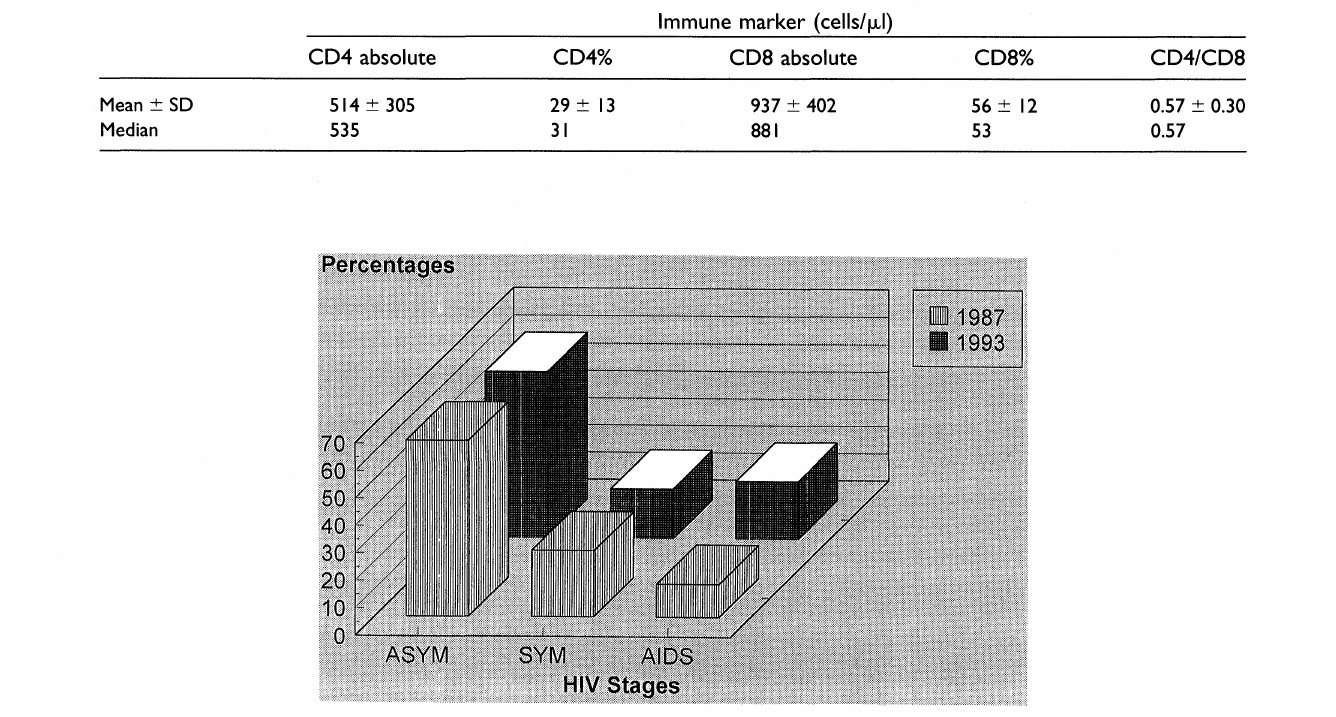
Fig. 3. HIV- -disease stage of newly identified cases of HIV- infection in pregnant women according to 1987 and 1993 CDC adult/adolescent definition. Asym asymptomatic; Sym